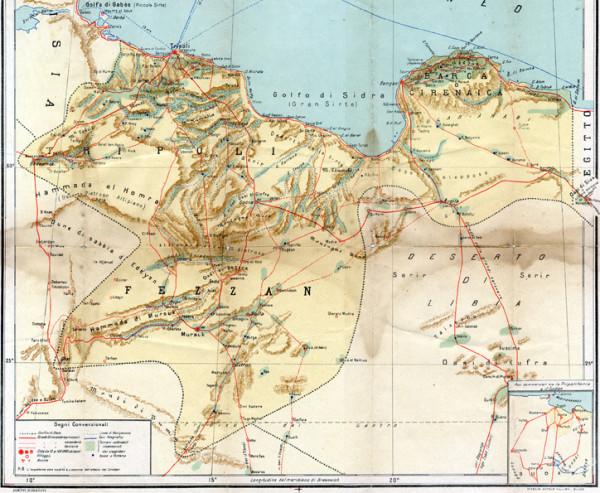
Geographical map of Libya in 1912 [4].